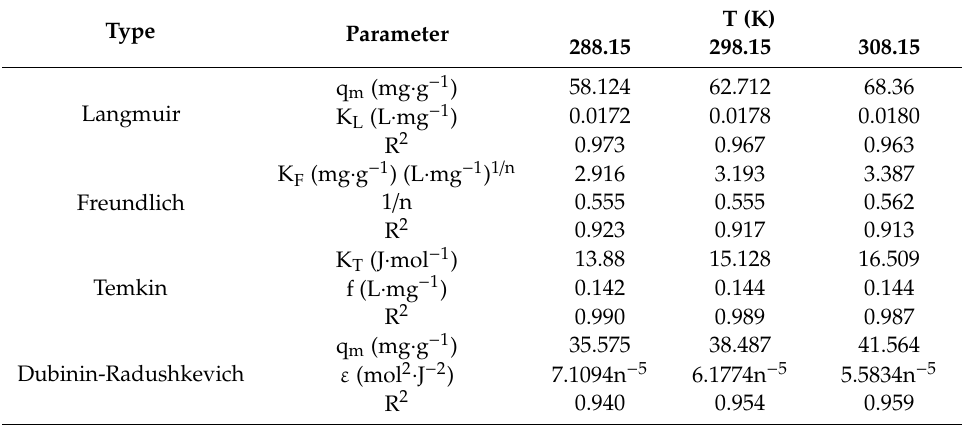
Figure 6. ( a ) E ff ect of initial CIP concentration on CIP adsorption by CA-Al-KABs, the fitting plots of ( b ) Langmuir, ( c ) Freundlich, ( d ) Temkin, ( e ) D-R isotherm models, ( f ) calculated values of R L (pH: 4, contact time: 1440 min, m / v: 0.04cg / 50cmL). C e , the concentration of CIP. Table 2. Fitting parameters of adsorption